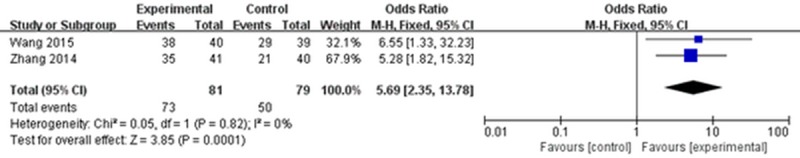
Forest plot of improvements in abdominal pain (fixed effects model).